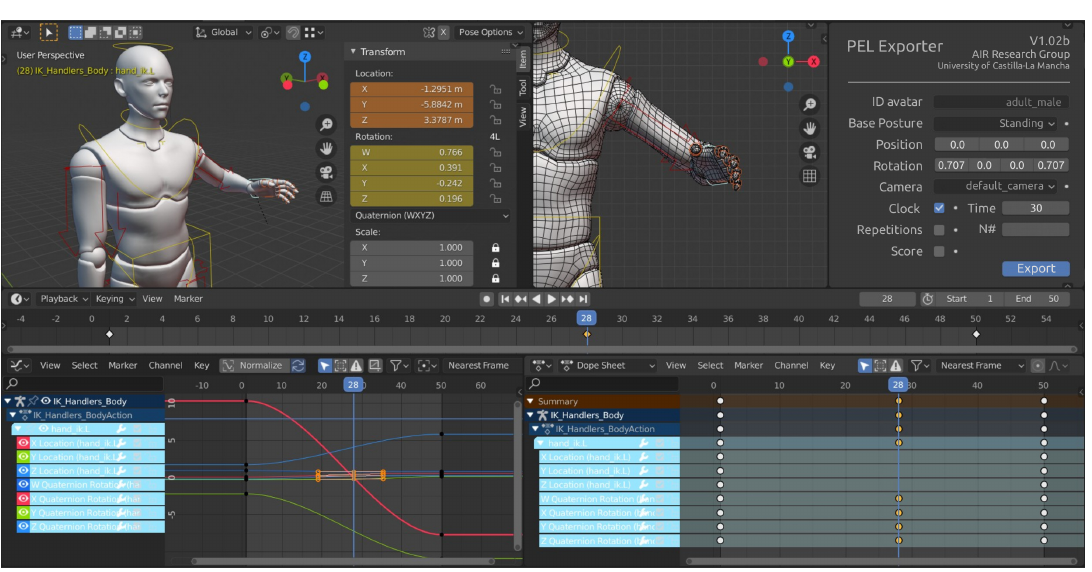
Figure 4. Plug-in view within Blender general interface. In the lower area, the Blender Timeline is shown, which will allow working with keyframes. On the right, the plugin will allow specifying the values of properties that will be later exported to PEL sentences (such as the virtual camera, the number of repetitions of the exercise, or the time-related